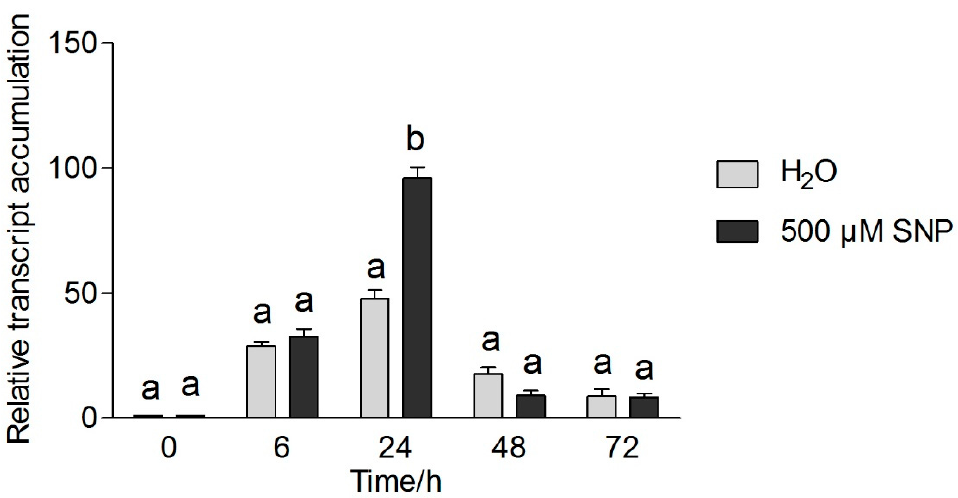
Figure 9. Expression of the CsCBF1 genes under cold stress.